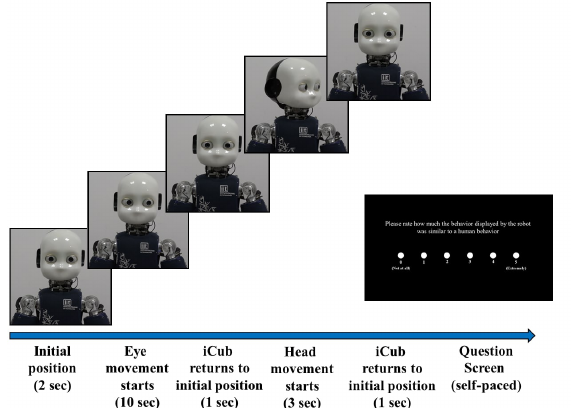
Figure 1: A planar view of the iCub robot used in this study. The pic- turedepictsthetypicaltrialsequence,illustratingtheiCub’sbehavior (staggered panels) and the subsequent human-likeness rating screen (bottom-right).Inthisexample,therobotmovesfromItoAandturns the head to the right.